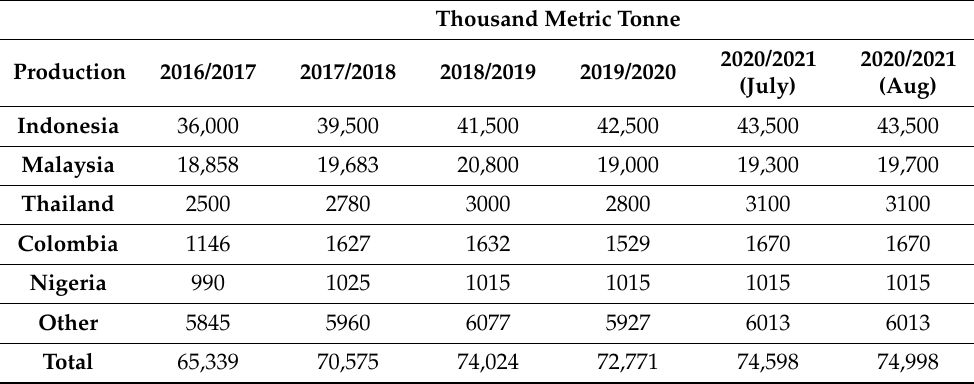
Table 1. Palm oil production globally from 2016 to 2020 (USDA, 2020)